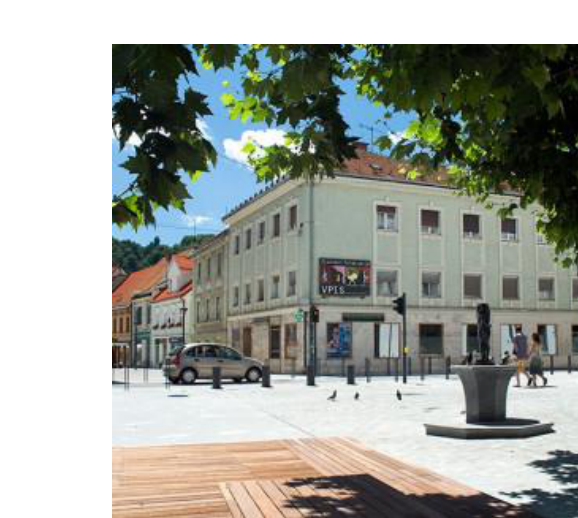
Fig. 9. The improvement of the climate through the use of fountains and the mosaics used in the paving of a street. *